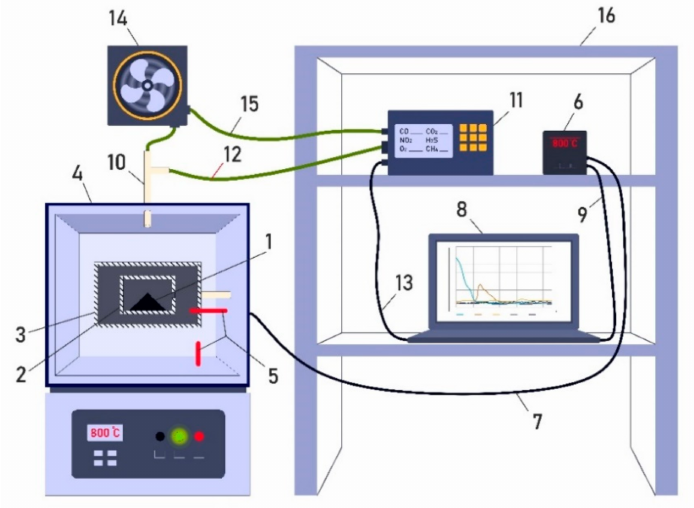
Figure 2. Schematic diagram of the experimental installation: 1–mixture particles, 2–fuel